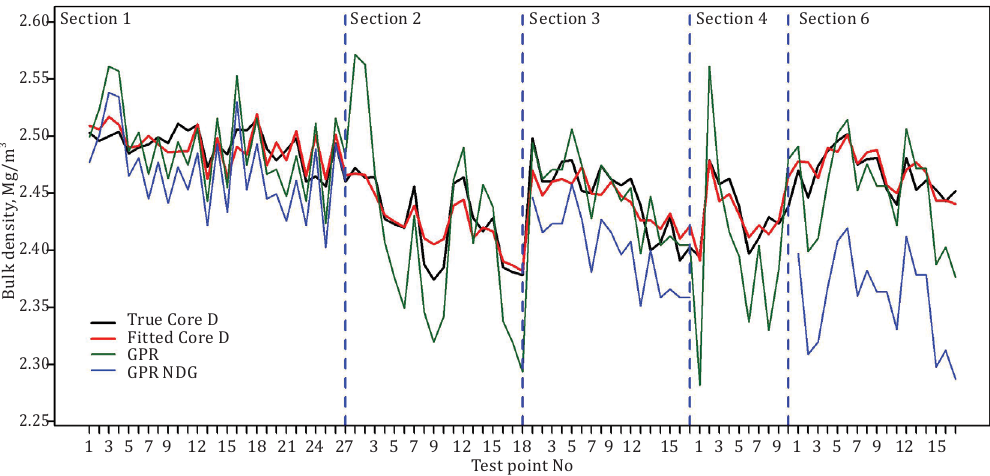
Figure 8. Distribution of asphalt density values